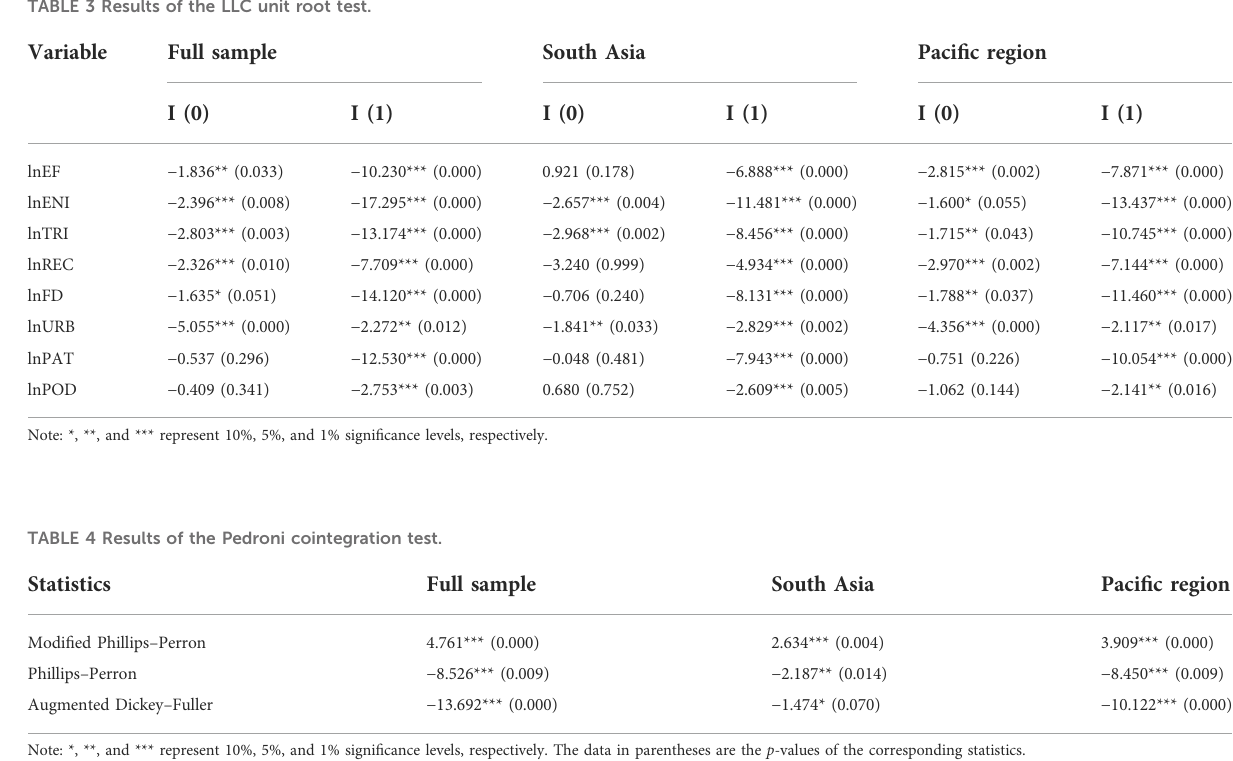
TABLE 3 Results of the LLC unit root test.